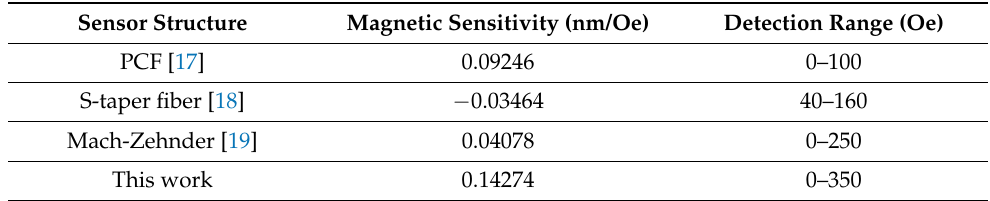
Table 1. Performance comparison of various optical fiber magnetic field sensors.